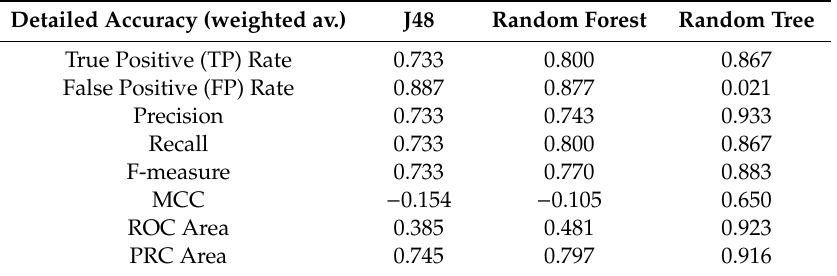
Table 9. Detailed precision parameters achieved by each algorithm for the R a ,90 prediction model. Detailed Accuracy (weighted